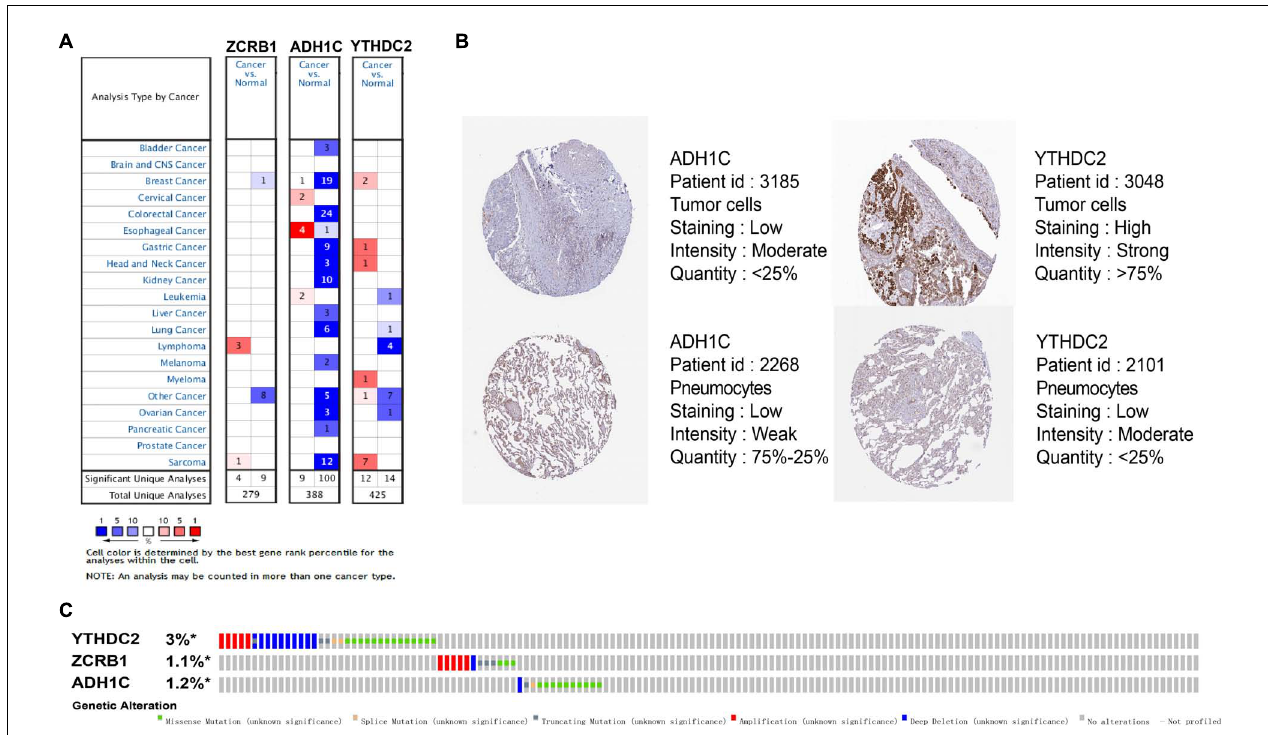
FIGURE 5 | Expression and genetic alterations of the three predictive genes. (A) The expression profiles of the three genes in the Oncomine database. (B) The representative protein expression of the three genes in LUAD and normal lung tissue in the Human Protein Atlas database. Data of ZCRB1 were not found in the database. (C) Genetic alterations of the three genes in LUAD in the cBioportal for Cancer